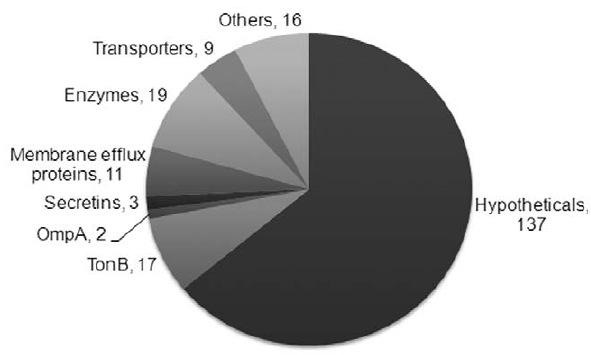
Figure 5. Pie chart classifying 228 OM b -barrel proteins according to function. Most M. xanthus OM proteins have no known function. The second major class of proteins includes TonBs, which are required for transport of a specific substrate. Transport of small molecules are carried out by transporters and OmpA, membrane efflux proteins are required for export of toxins and secretins form a large OM pore that allow export by Type II secretion system.